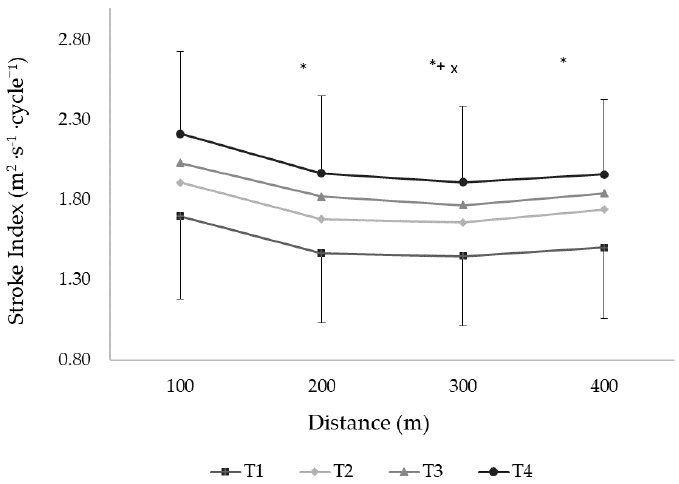
Figure 3. The stroke index in each 100 m split of the 400 m front crawl effort at testing moments T1, T2, T3, and T4. T1: beginning of the first macrocycle; T2, T3, and T4: end of the first, second, and third macrocycles, respectively. * and +: p < 0.05 compared to 100 m and 400 m. . x : p < 0.05 compared to 200 m partial.